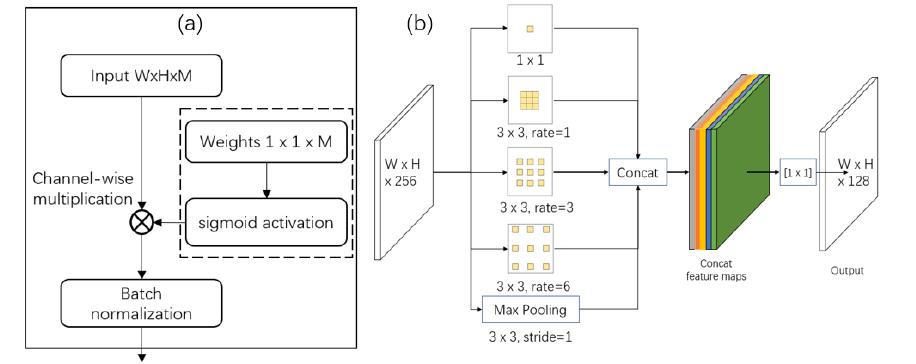
Figure 4. The architecture of DaSNet-C model. DaSNet-C has the independent GFPN and the feature processing block for processing of detection and segmentation tasks separately.